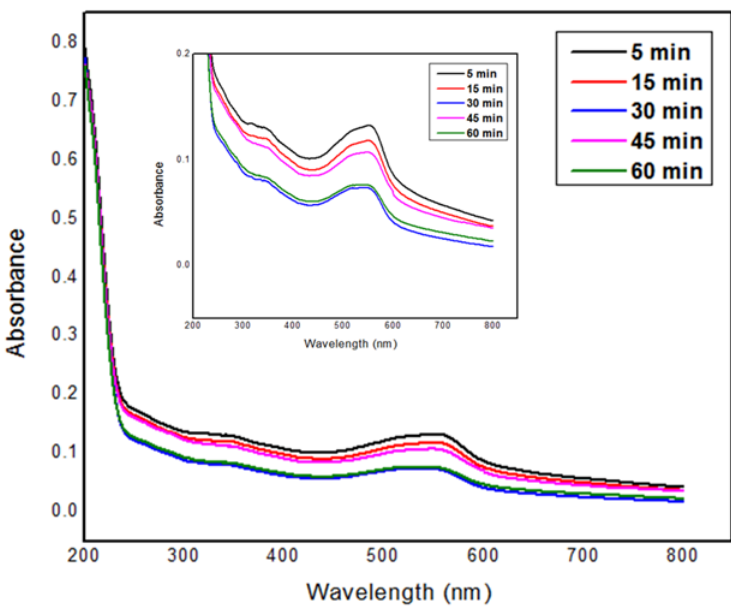
Figure 5. UV-Vis spectra of Ag/CuO NPs formation.